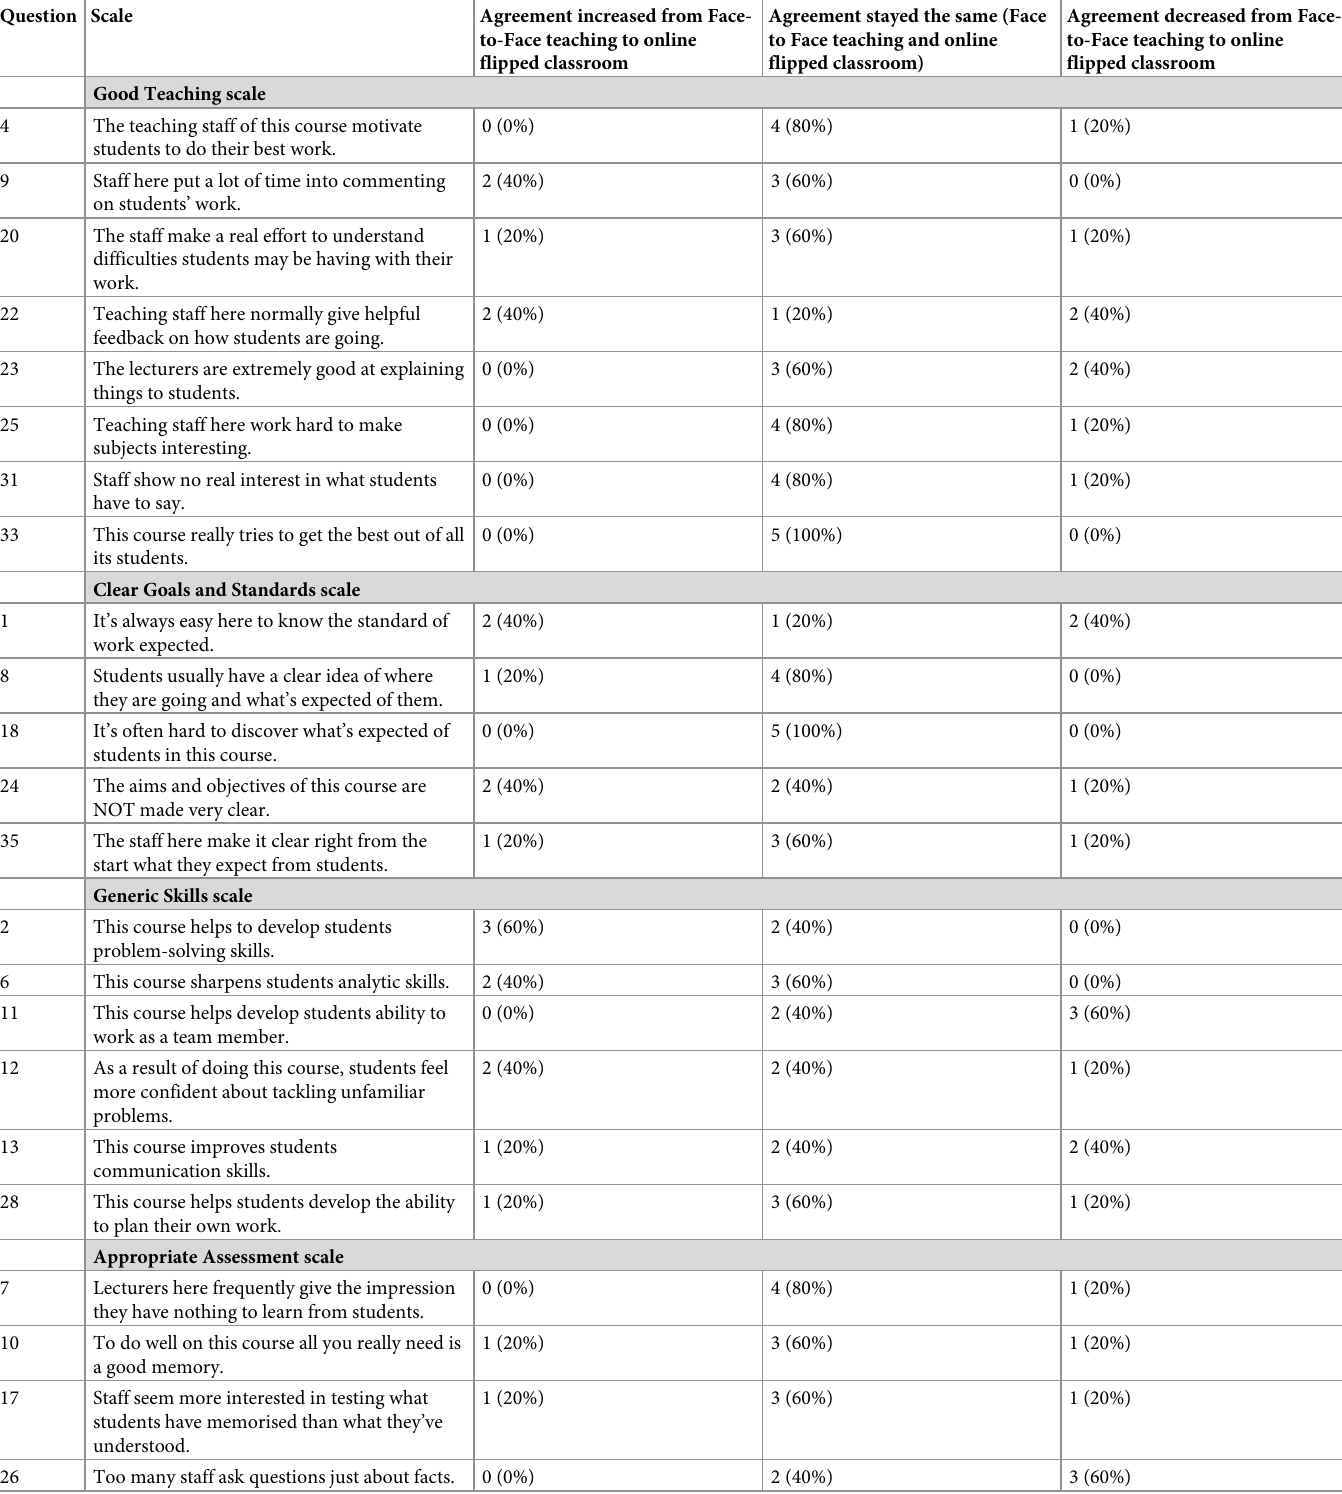
Table 5. Comparison of faculty trends in agreement from face-to-face teaching to online flipped